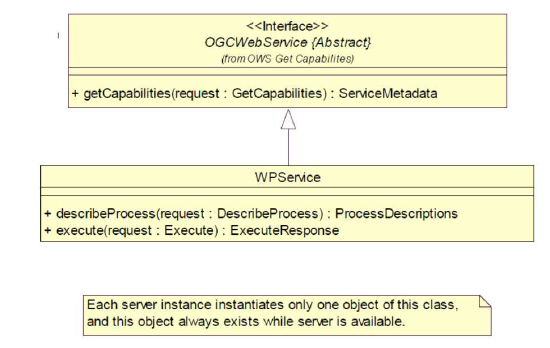
Figure 3. The WPS operations (Schut, 2007).